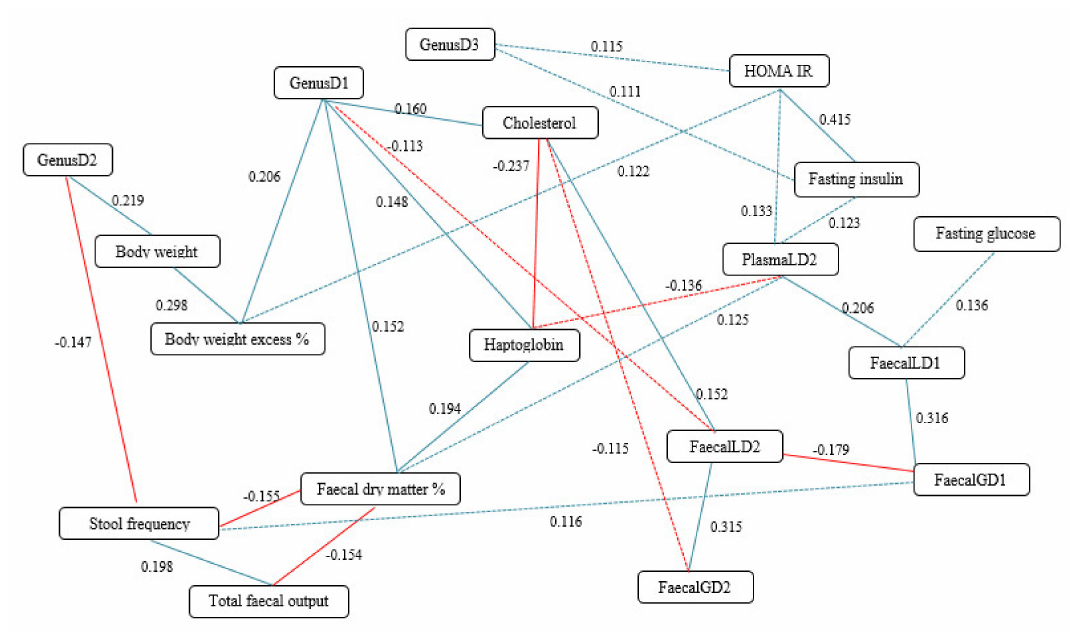
Figure 5. Diagram of the di ff erent partial correlations resulting between phenotypic parameters and metagenomic and metabolomic metavariables in obese dogs. In blue: positive partial correlation; in red: negative partial correlation. Solid line: p value < 0.01 and Q value < 0.05; Dotted line: p value < 0.05 and Q value <